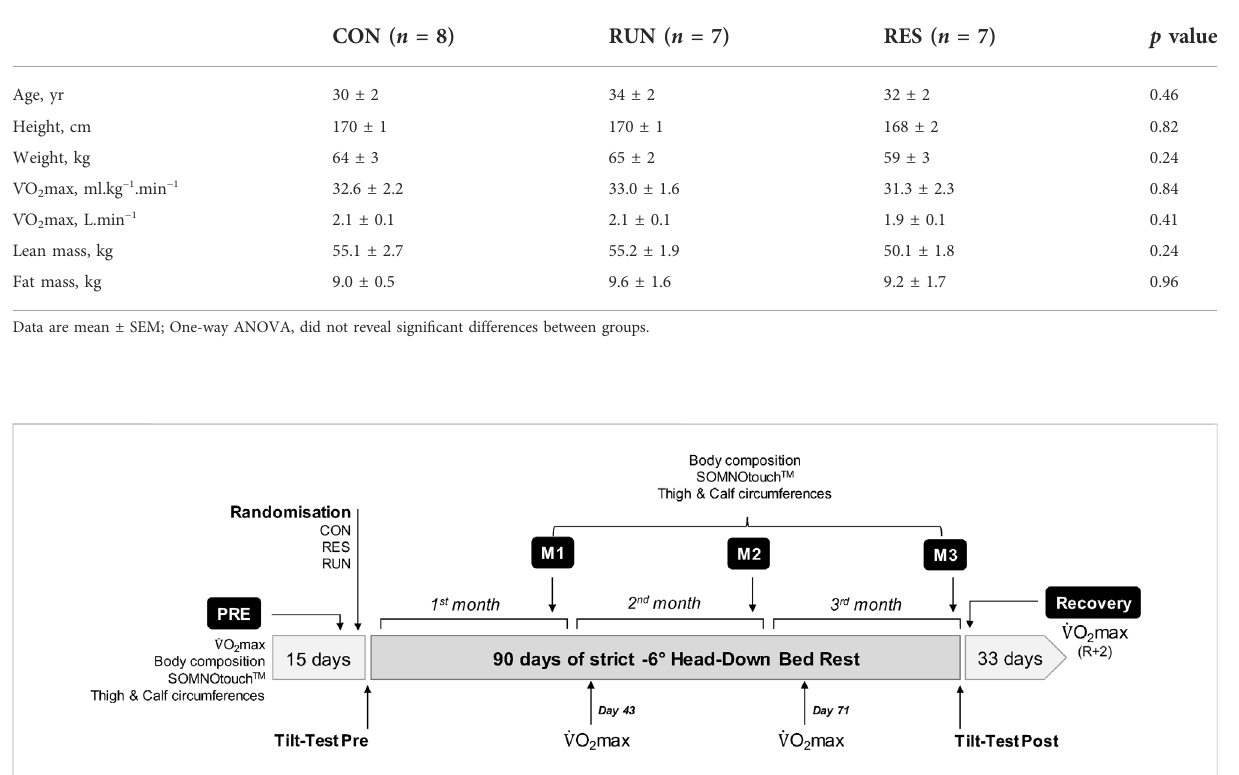
TABLE 1 Baseline anthropometric data.